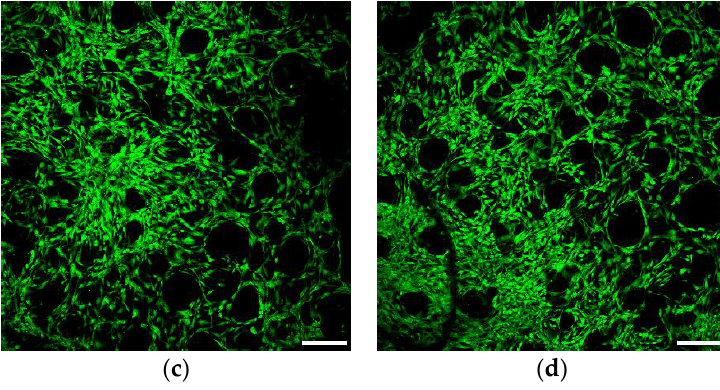
Figure 16. Confocal images of fluorescently labeled hMSCs cultured on 500 µm pore scaffolds ( a ); 500 µm shell of the bimodal pore scaffolds ( b ); 200 µm core of the bimodal pore scaffolds ( c ); and 200 µm pore scaffolds ( d ) for 24 h. Scale bar of 200 µm.